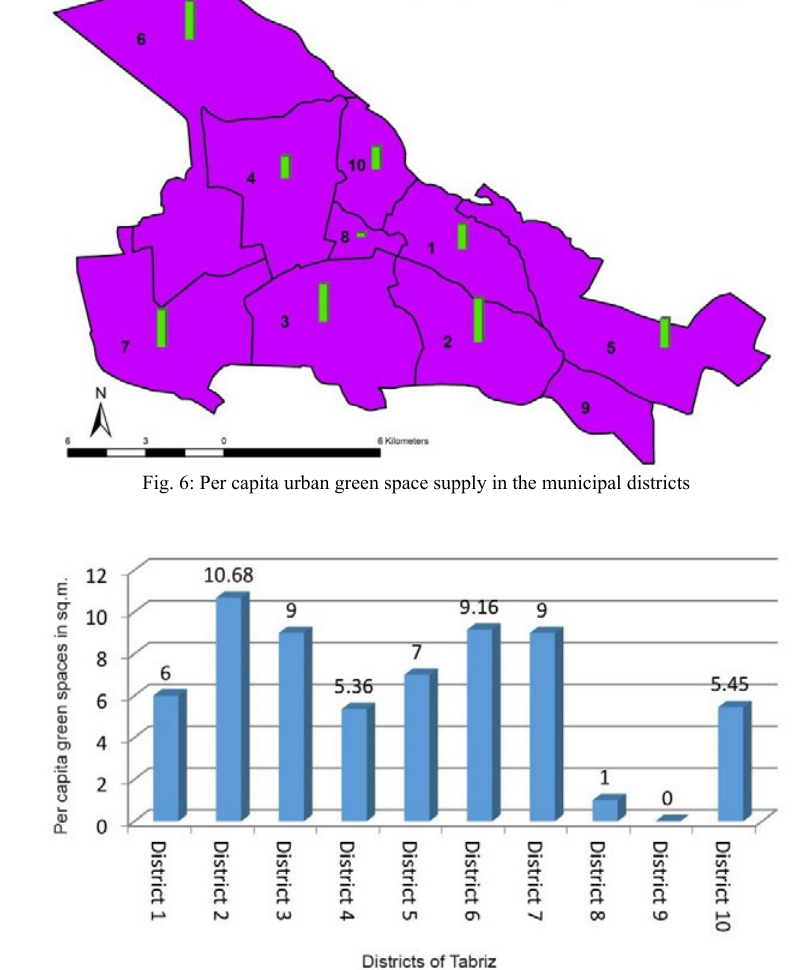
Fig. 7: Per capita urban green space supply in the municipal Fig 7: Per capita urban green space supply in the municipal districts